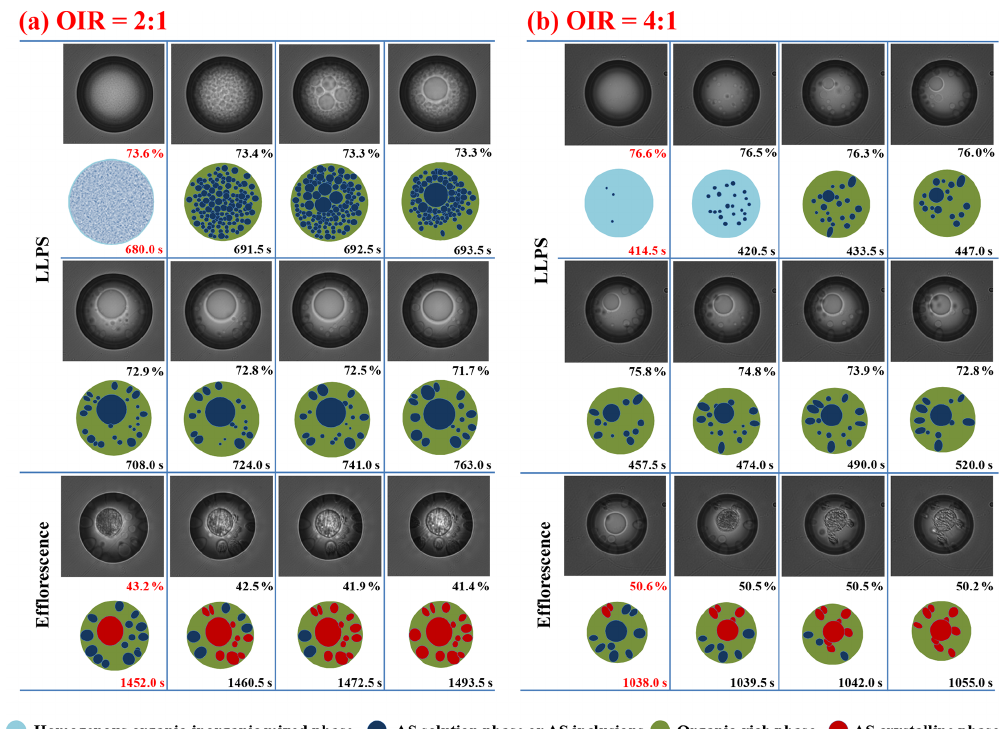
Figure 7. Optical images and corresponding illustrations of mixed 1, 2, 6-hexanetriol / AS particles with OIR = 2 : 1 (a) and 4 : 1 (b) during LLPS and efflorescence. Below the optical images are the illustrations. The corresponding RH and time are given in each frame. The RH and time in red indicate the occurrence of phase